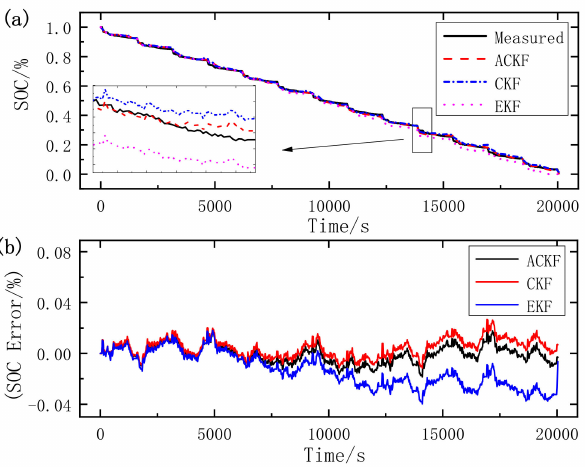
Figure 8. SOC simulation results in UDDS: ( a ) SOC; ( b ) SOC error.